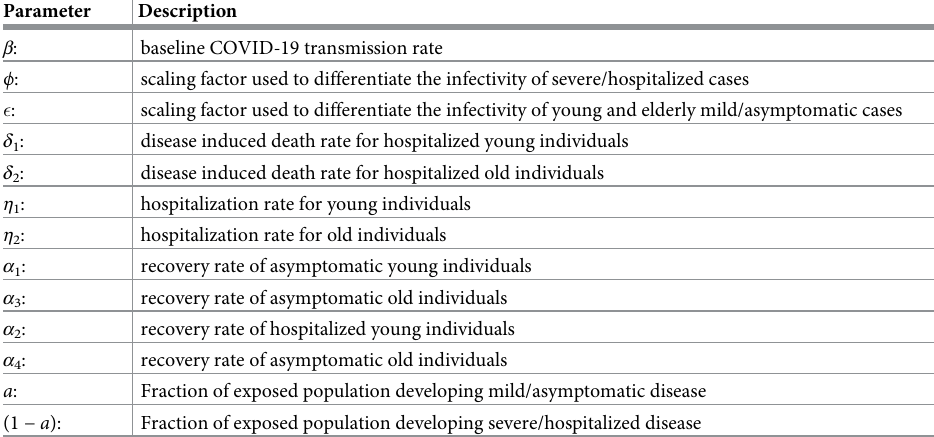
Table 1. Description of model framework